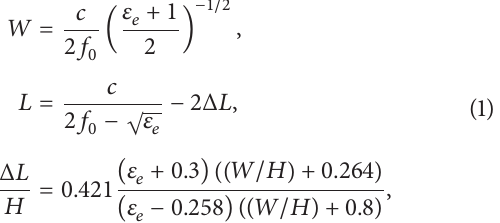
Figure 2. The maximum return loss ( |𝑆 11 | ) can be obtained at 𝑑 2 = 4.6 mm. At this place, the best impedance matching at 4.5 GHz and 5.06 GHz is observed. The optimized parameters of the antenna are listed in Table